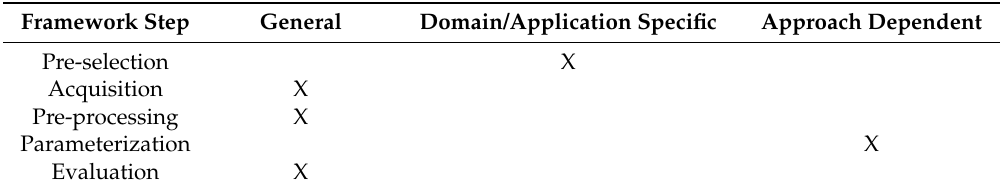
Table 1. General and adaptable parts of the